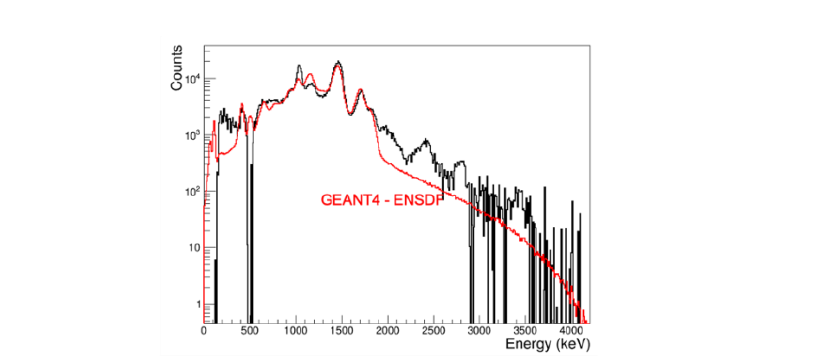
Fig. 3. TAS spectrum of the beta decay of 64 Ge (black) compared to the Geant4 simulation of the same decay in the same detector using ENSDF data